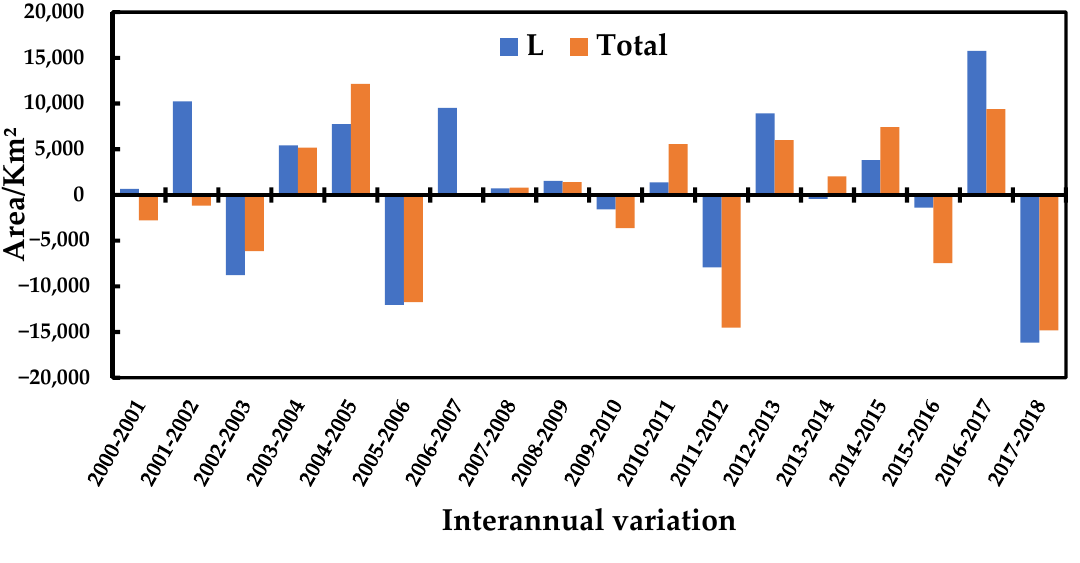
Figure 8. Interannual variability of the area of light desertification and total desertification in Mu Us Sandy Land from 2000 to 2018. L—light desertification, Total—total desertification.